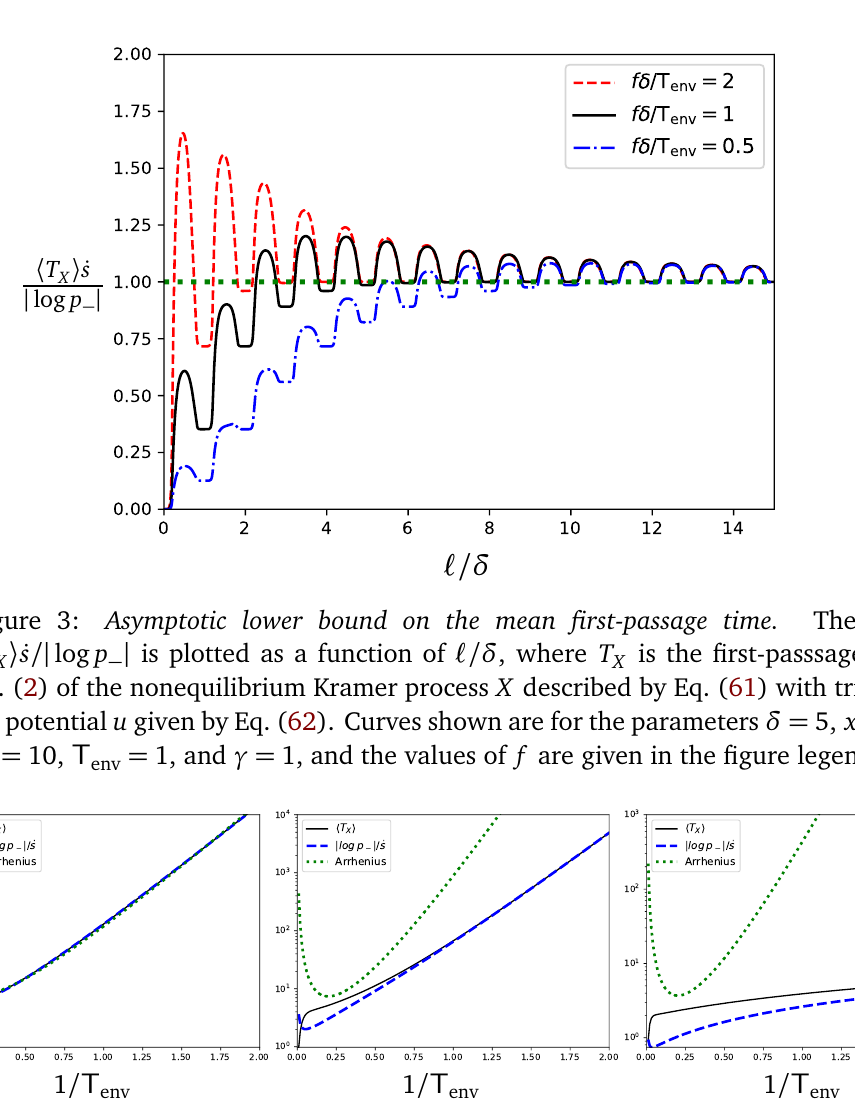
Figure 4: Extension of the Van’t Hoff-Arrhenius law to nonequilibrium stationary states. 〉 (solid black line) of the reaction coordinate X , The mean-first passage time 〈 T X described by Eq. (61) with triangular potential u given by Eq. (62), is plotted as 〉 is also compared with its a function of the inverse temperature 1 / T , and 〈 T X env asymptotic value | log p − | / ˙ s for large thresholds (cid:96) (blue dashed line) and with the Van’t Hoff-Arrhenius law Eq. (72) (green dotted line). The model parameters are δ = 5, x ∗ = 1, u = 10, T = 1 and γ = 2 and the values of f are f = 1, f = 5 and 0 env f = 10 from left to right, respectively. The threshold for the first-passage time T , X which is defined in Eq. (65), is (cid:96) =